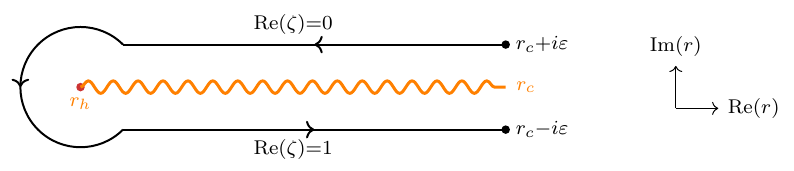
Figure 1 . The complex r plane with the locations of the two boundaries and the horizon marked. The grSK contour is a codimension-1 surface in this plane (drawn at fixed v ). As indicated the direction of the contour is counter-clockwise and it encircles the branch point at the horizon. The left SK boundary (denoted L) is located at r + iε , while the right boundary (denoted R) is at r c c − iε